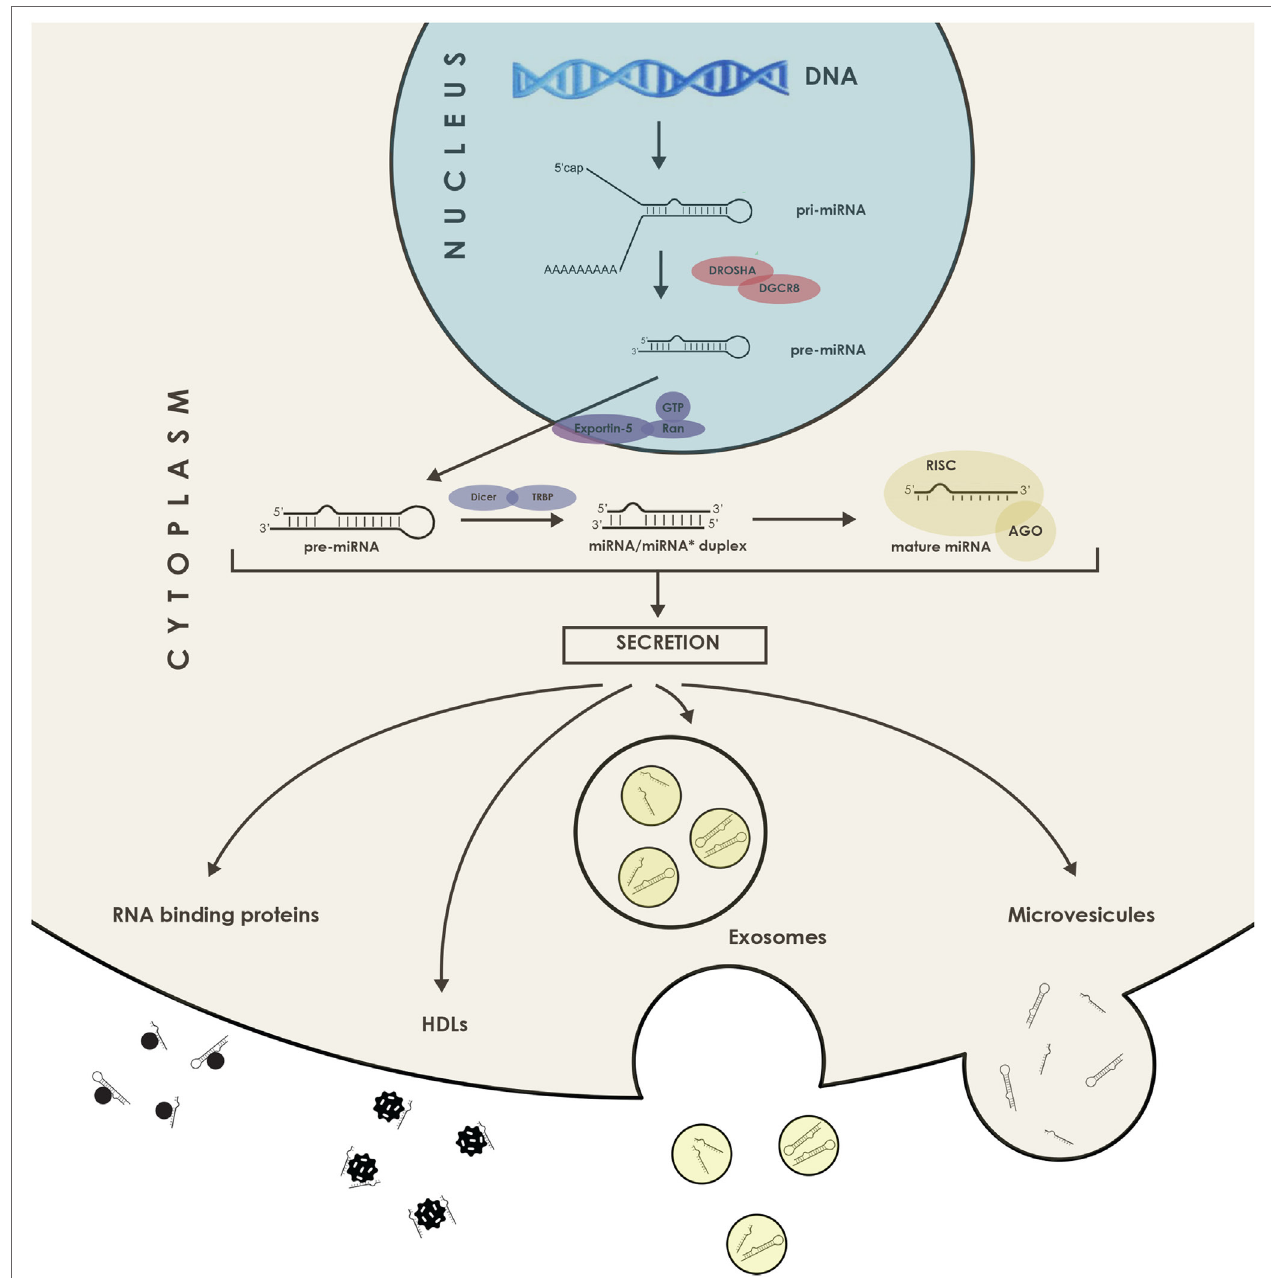
FigURe 2 | Schematic representation of the microRNAs (miRNAs) secretion. miRNAs can be exported bound to proteins such as RISC and Argonaute 2, or even in association with high-density lipoprotein (HDL) lipoprotein complexes as well as in the form of miRNAs packed in extracellular vesicles, such as microvesicles and exosomes. DGCR8, DiGeorge syndrome chromosomal (or critical) region 8 subunit; TRBP, TAR RNA binding protein; AGO, Argonaute; RISC, RNA-induced silencing complex.